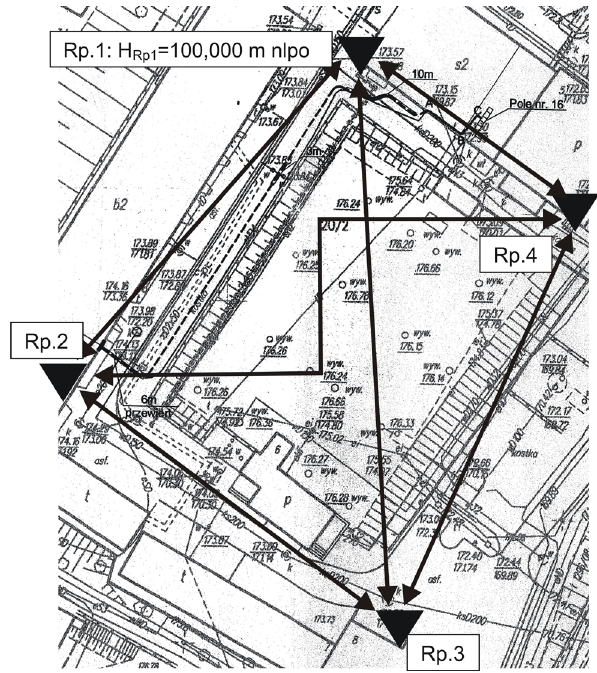
Figure 13: The benchmark control levelling